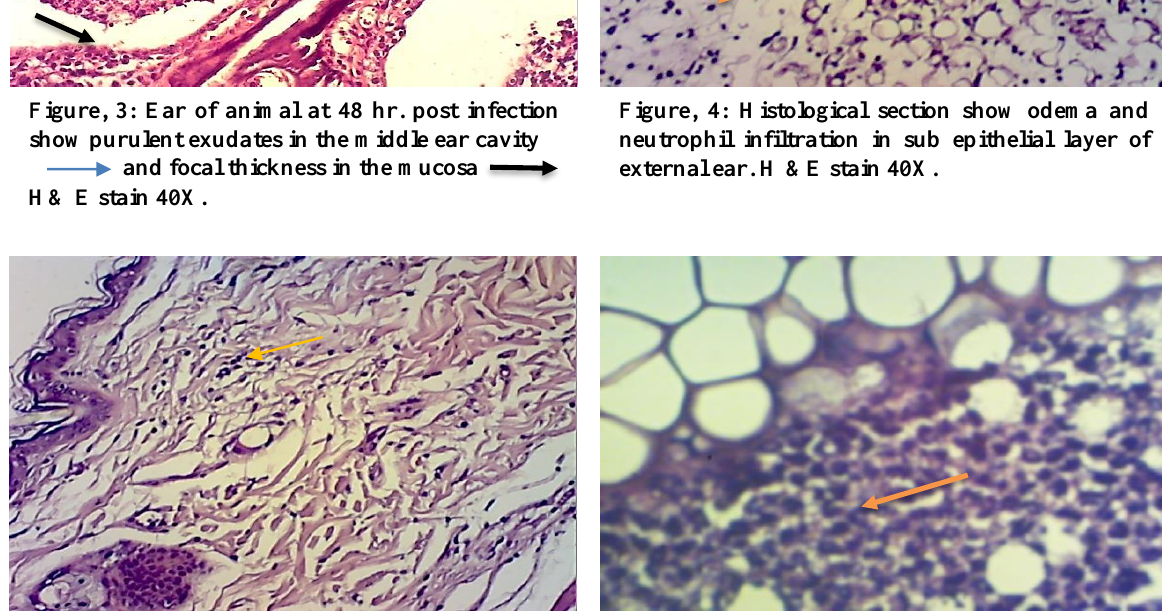
Figure, 6: Histological section shows market molecular cell infiltration in a deposition tissue of ear. H & E stain 40X.